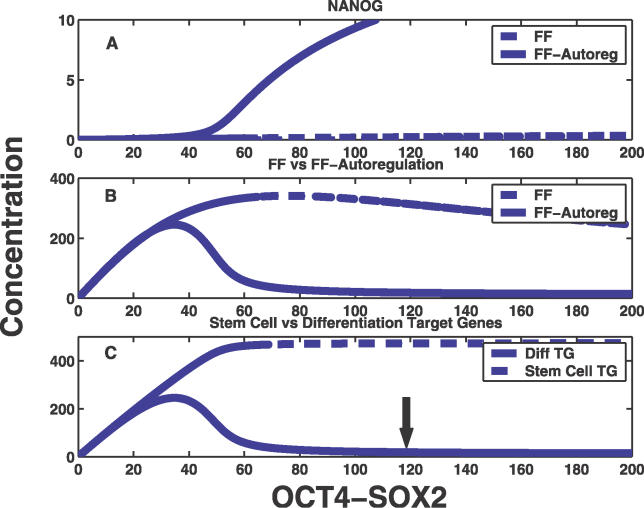
Steady State Concentrations of NANOG and the TGs as Functions of the Input OCT4–SOX2 Concentration [OS] for the Feedforward Motif with Autoregulation (FF-Autoreg) as well as the Feedforward Motif with No Autoregulation (FF)(A) NANOG.(B) TGs.(C) Concentrations of the stem cell and differentiation TGs as a function of [OS] are shown. The arrow in (C) indicates that if such a value of [OS] is reached, then the differentiation TGs could be shut off, whereas the stem cell TGs would be on. Thus the same incoherent architecture for both sets of genes achieves the desired result.